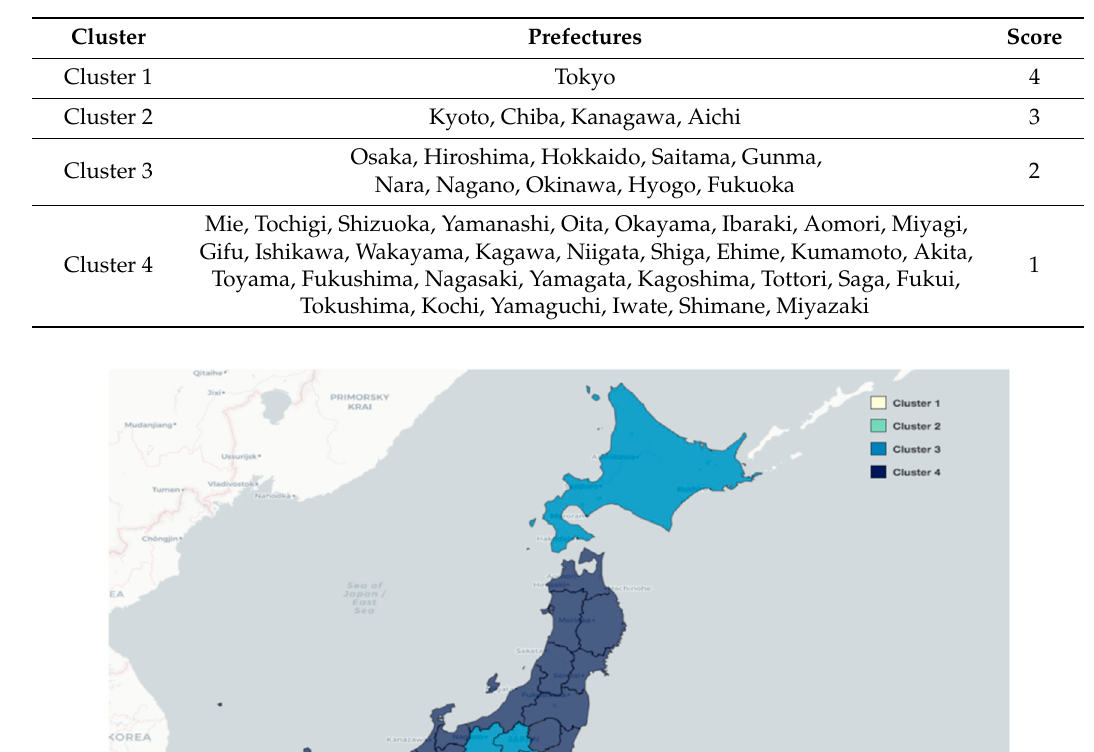
Table 2. Clustering result of prefectures.